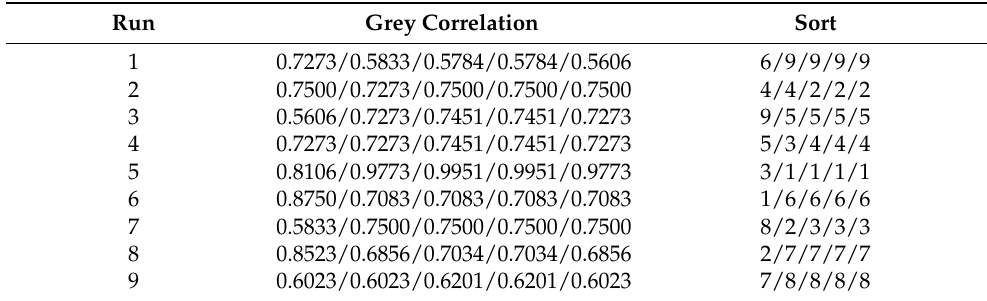
Table 6. Arrangement of the grey relation of POM/ABS/PP/PA/ABS + PC materials and the best plan.